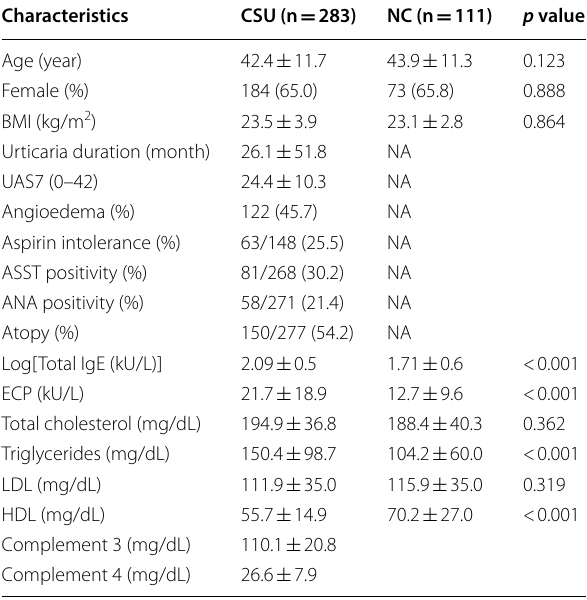
p values were obtained by Chi square test for categorical variables and Mann– Whitney U-test for continuous variables CSU chronic spontaneous urticaria, NC healthy normal control, BMI body mass index, NA not assessable, UAS7 urticaria activity score over 7 days, ASST autologous serum skin test, ANA anti-nuclear antibody, ECP eosinophilic cationic protein, LDL low density lipoprotein, HDL high density lipoprotein